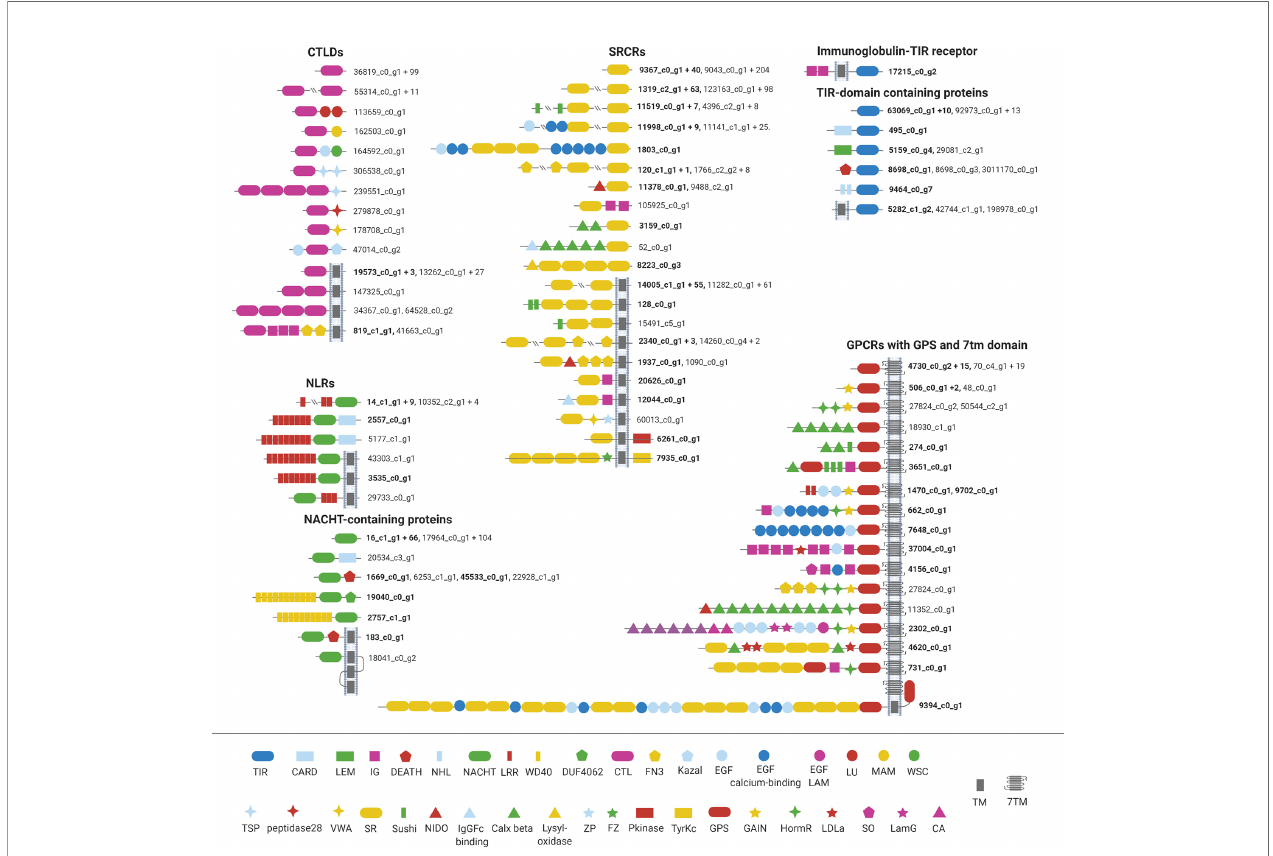
FIGURE 1 | The repertoire of pattern recognition receptors in Halichondria panicea. The PRR families GPCRs, SRCRs, CTLD genes, NLRs and TIR-domain receptors were identi fi ed based on conserved Pfam domains. Identi fi cation numbers of representative transcripts are shown next to protein models, and bold IDs indicate constitutive expression (i.e. present in each analyzed sponge). The number of additional transcripts with the same protein domain architecture is given behind the representative ID. TIR, Toll/interleukine-1 receptor; CARD, caspase recruitment domain; LEM, in nuclear membrane associated proteins; IG, immunoglobulin; NHL, repeat; LRR, leucine-rich repeat; WD40, repeat of 40 amino acids typically terminating in Trp-Asp; DUF4062, conserved domain of unknown function; CTL, C-type lectin; FN3, fi bronectin III; Kazal, part of serine protease inhibitors; EGF, epidermal growth factor; EGF-calcium-binding, epidermal growth factor calcium-binding; EGF-LAM, Laminin-type epidermal growth factor-like; LU, Ly-6 antigen/uPA receptor-like; TSP, Thrombospondini domain; peptidase28; VWA, von Willebrand factor; SR, scavenger receptor cysteine-rich; ZP, zona pelludica; FZ, frizzled domain; Pkinase, phosphate kinase; TyrKc, tyrosine-speci fi c kinase; GPS, G-protein-coupled receptor proteolytic site; HormR, present in hormone receptors; LDLa, low density lipoprotein receptor class A repeat; SO, somatomedin B- like; LamG, laminin G; CA, cadherin repeat; TM, transmembrane region; 7TM, 7 helix transmembrane domain. Other domains: DEATH, NACHT, MAM, WSC, Sushi, NIDO, IgGFc-binding, Calx-beta, Lysyl-oxidase, GAIN. The Figure was created with